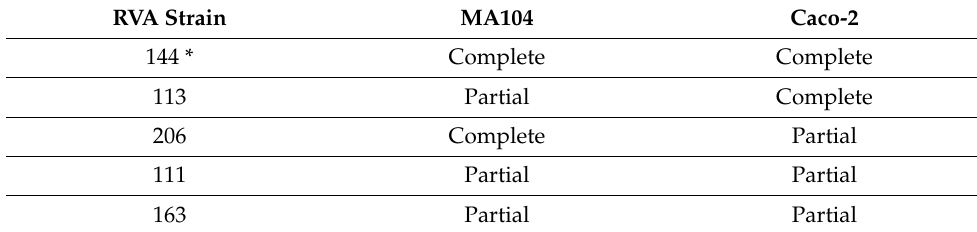
Table 3. Cytopathic effect of the isolated RVA strains.